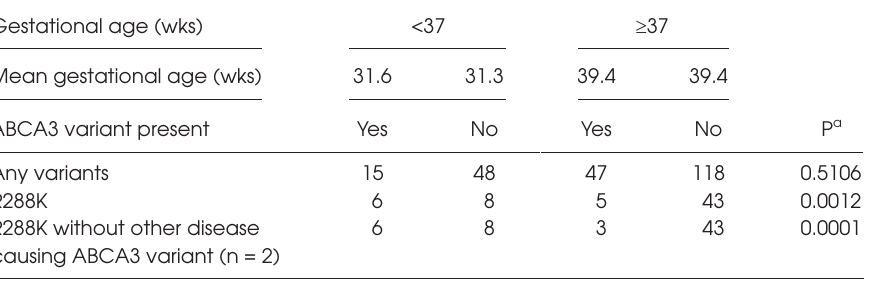
table 1. Frequencies of ABCA3 variants among 228 neonates and infants (mean gestational age 35.4 wks) sequenced for ABCA3 variants and interstitial lung